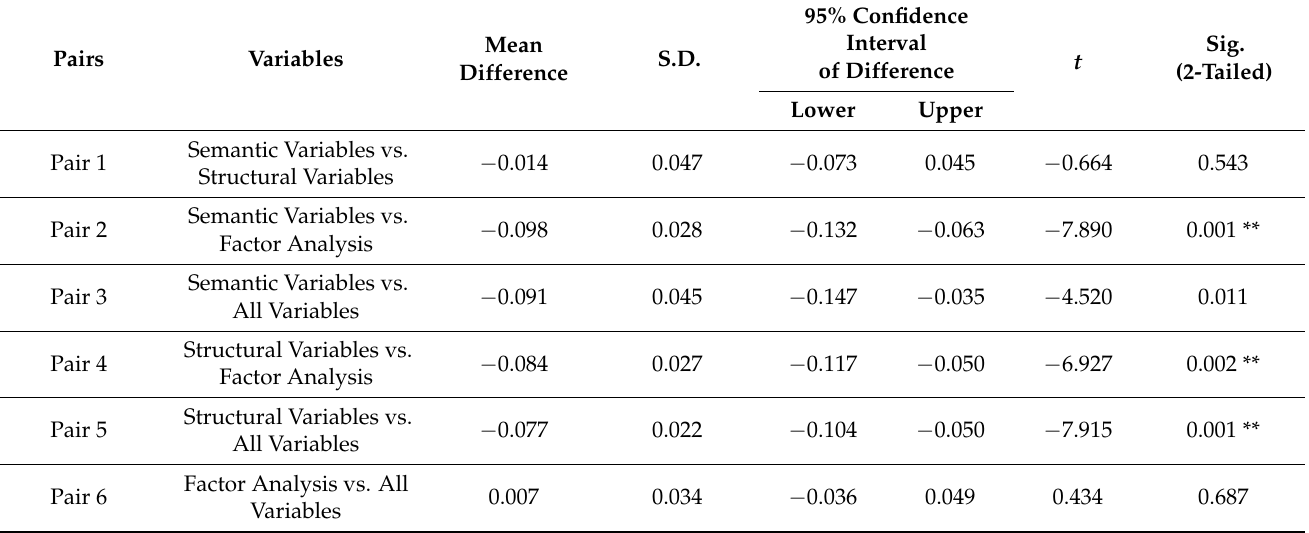
Table 10. Paired-sample t -test of differences in